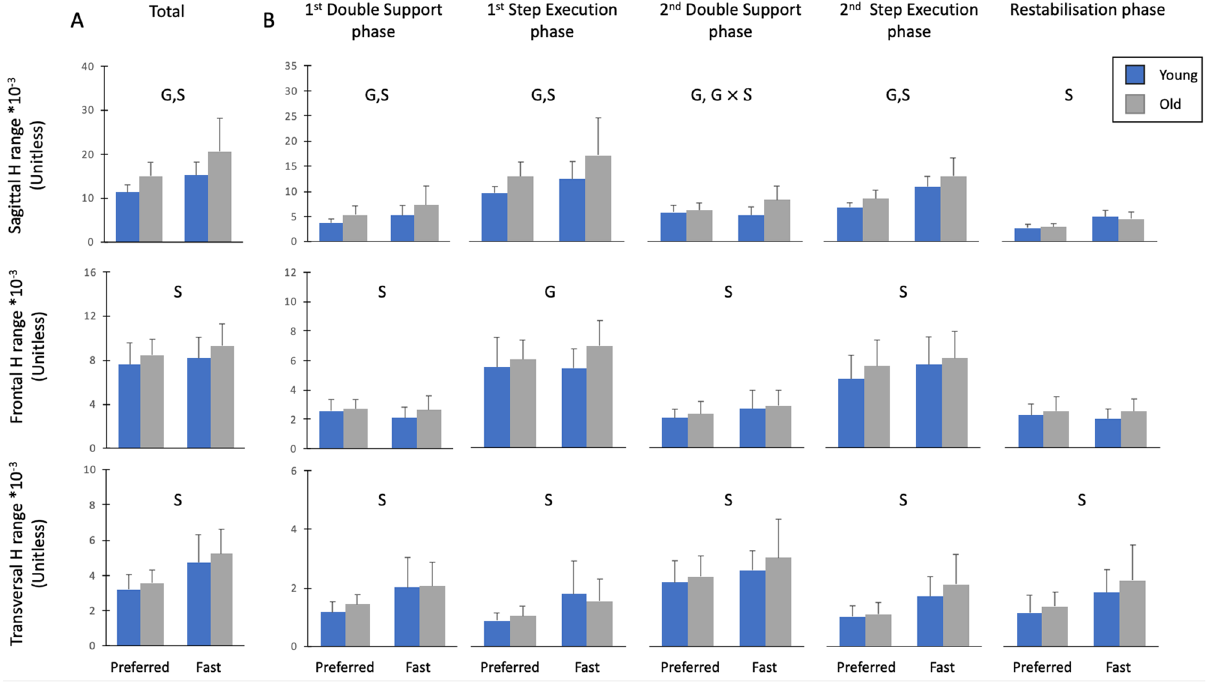
Figure 3. The sagittal, frontal and transversal mean values ± SD of ranges of normalized whole-body angular momentum (H) for old and young individuals. Mean ranges of normalized H were presented for the preferred and fast conditions. H was normalized by body mass, body height and (cid:31) g · l ( g = 9.81 m s -2 and l = body height). ( A ) H range computed over the entire duration of the movement (Total H range). ( B ) Ranges of H in frontal, transversal and sagittal planes for all stepping phases. ‘G’ indicated significant differences between old and young individuals. ‘S’ indicated significant differences between the preferred and fast speed conditions. ‘ G × S ’ indicated significant Group × Speed